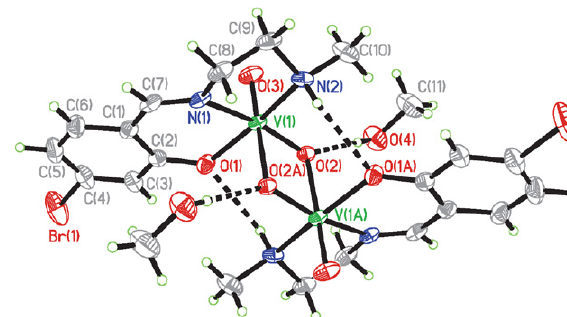
Fig. 8. Molecular packing diagram of complex 4 , viewed along the b axis. Hydrogen bonds are drawn as dashed lines.